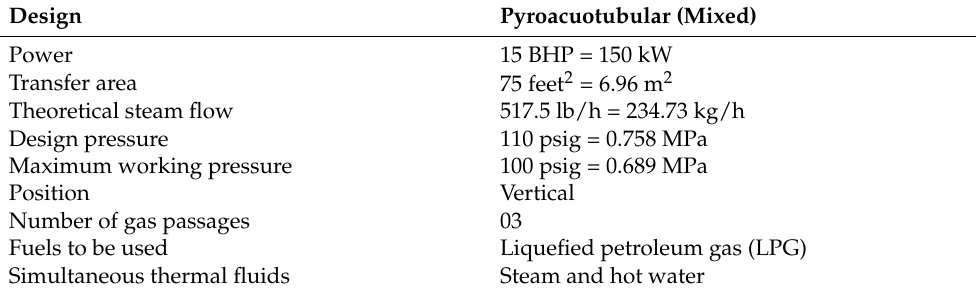
Table 1. Technical specifications.